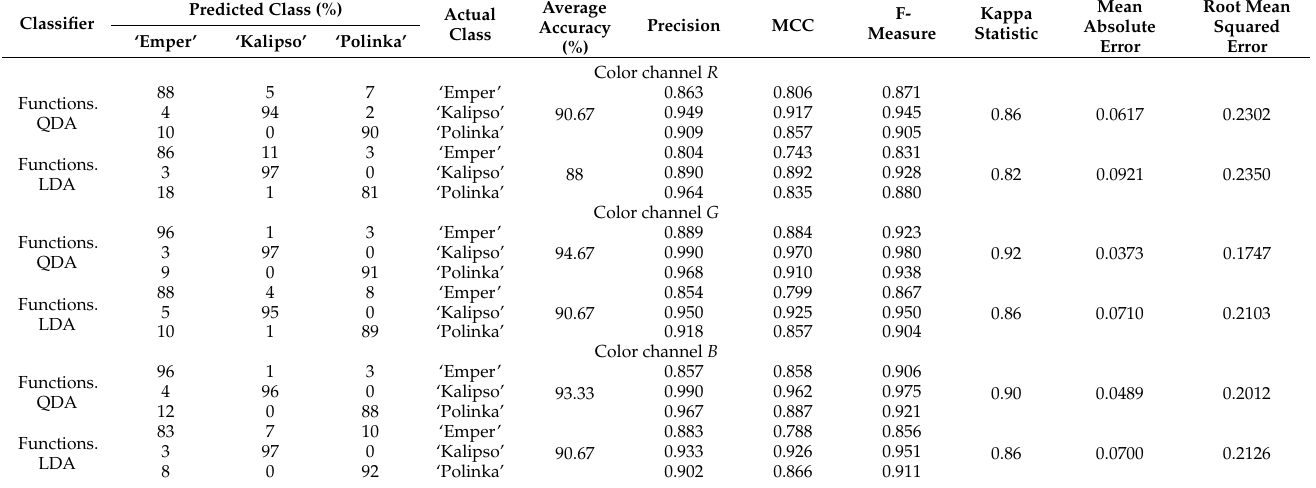
Table 2. The results of cultivar discrimination of plum stones based on textures selected from individual color channels R , G , and B